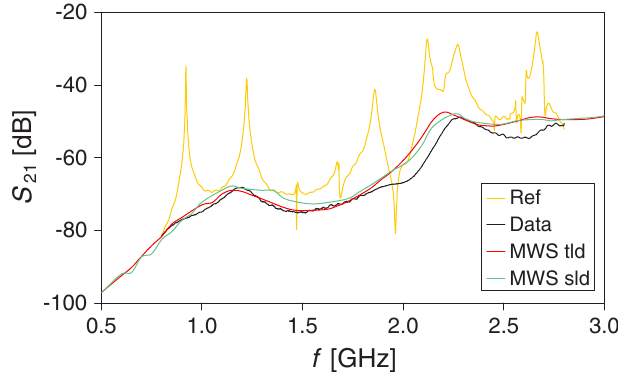
FIG. 5. (Color) Measured S 21 for the absorber (Data) and a reference cavity (Ref) and curves simulated (MWS) with (cid:3) (cid:4) 4 ð 1 (cid:1) j 2 : 5 Þ at 1 GHz and " (cid:4) 13 .